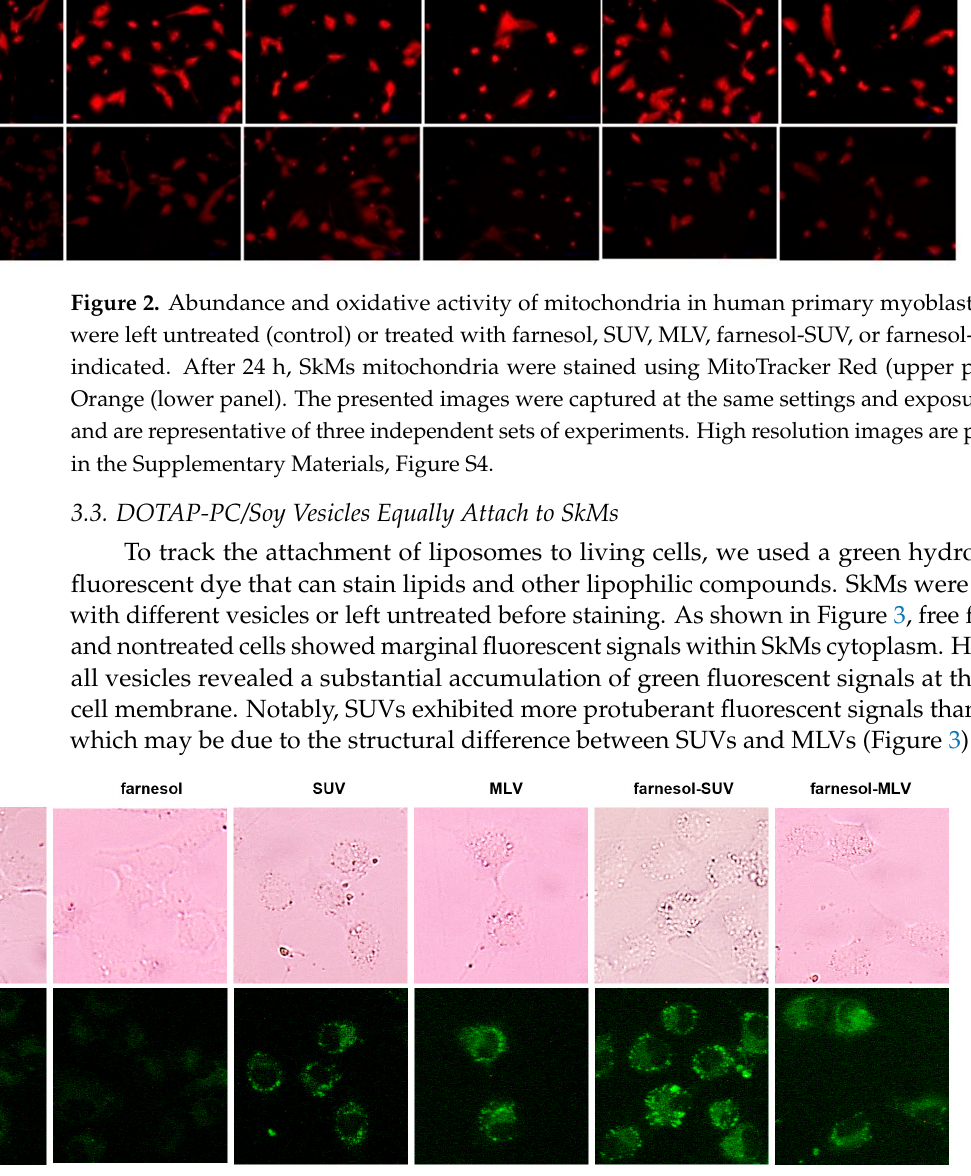
Figure 3. Nanovesicles equally attach to SkMs. SkMs were not treated (control) or treated with farnesol, SUV, MLV, farnesol-SUV, or farnesol-MLV, as indicated. After 24 h, SkMs were stained using BODIPY. Transmitted light (TL, upper panel) and fluorescence (FL, lower panel) images were captured at the same settings of magnification and exposure times. High resolution images were provided in Supplementary Figure S5.